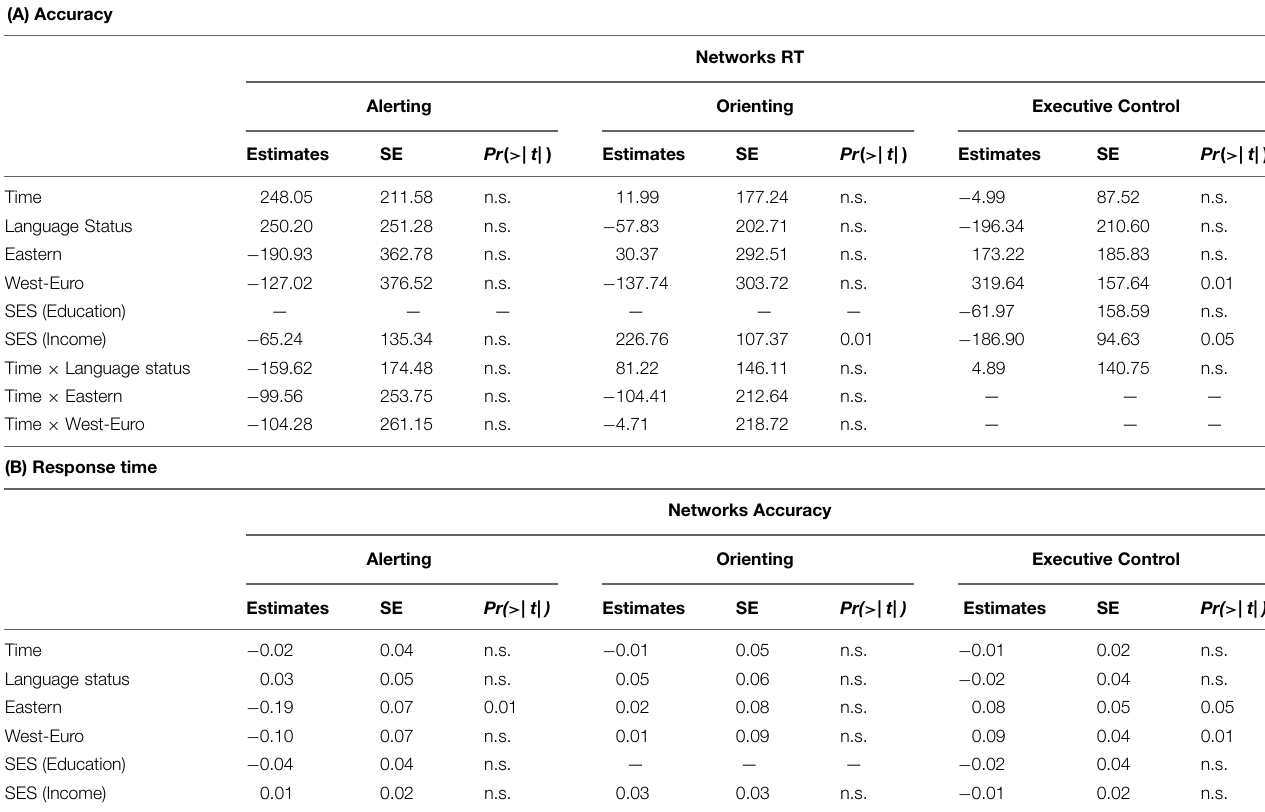
TABLE 5 | Parameter estimates for individual network models (Accuracy and